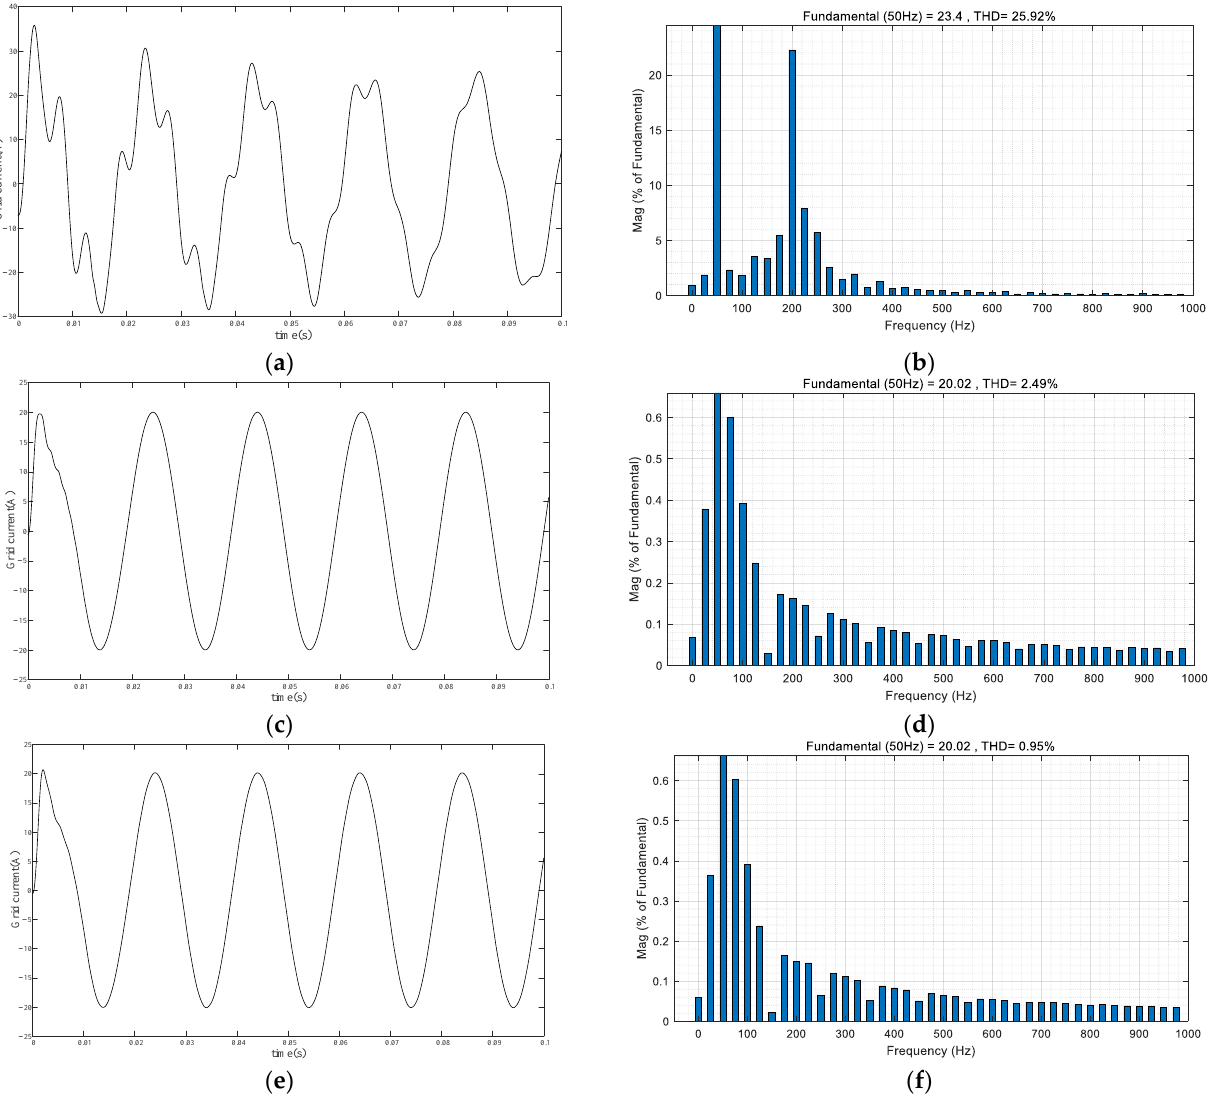
Figure 10. Simulation results under weak grid conditions. ( a ) Grid current under conventional control; ( b ) THD analysis of grid current under conventional control; ( c ) Grid current under ADRC + PBC; ( d ) THD analysis of grid current under ADRC + PBC; ( e ) Grid current under FUZZY - ADRC + PBC; ( f ) THD analysis of grid current under FUZZY - ADRC + PBC.